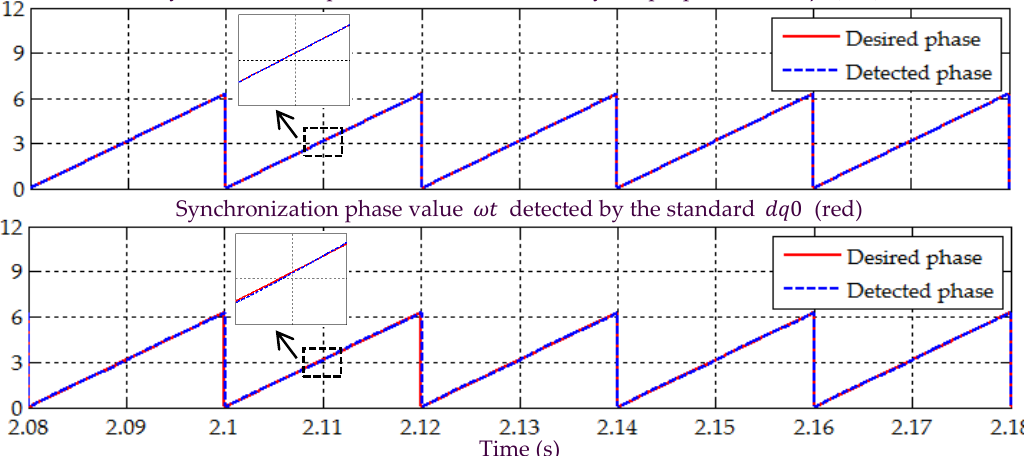
Figure 15. Simulation result showing the detected synchronization reference phase value 𝜔𝑡 under Scenario C. Table 4. Comparative analysis of the proposed STF- dq 0 and the standard dq 0 techniques under Scenario C.